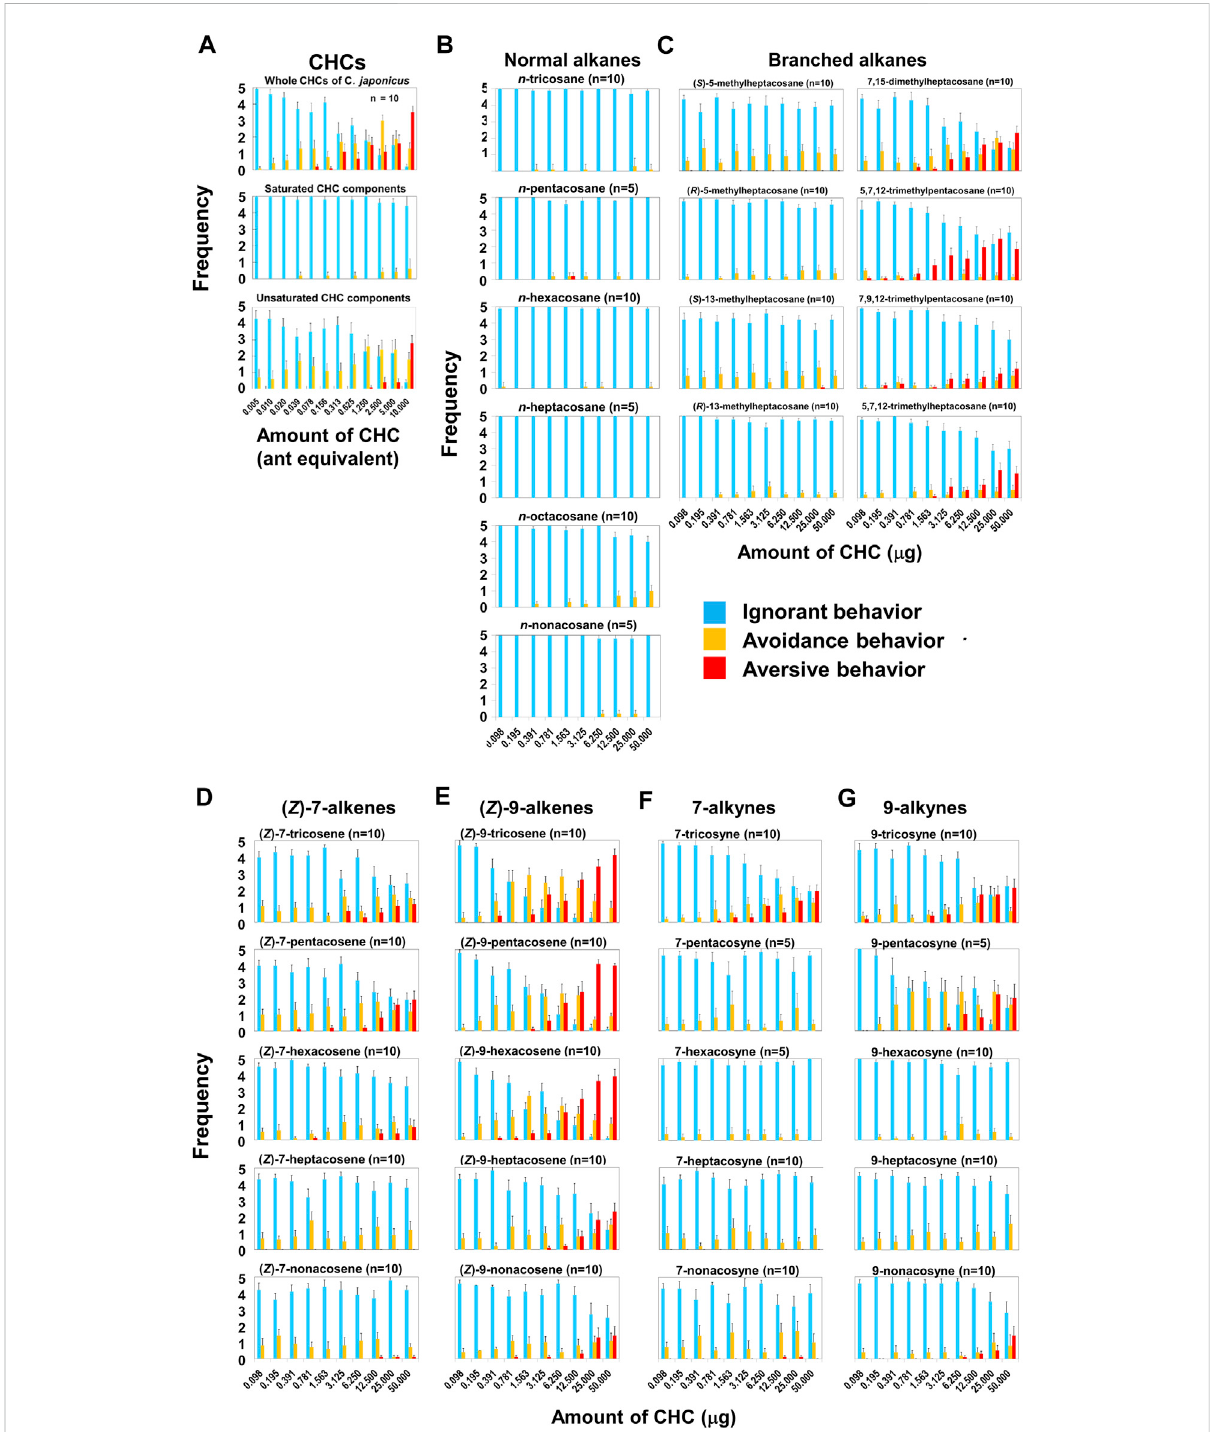
Behavioraleffectsof C.japonicus cuticularhydrocarbons(CHCs)andrelatedsyntheticcompoundson L.humile . (A) Behavioraleffectsofwhole C. japonicus CHC extracts (Top), and puri fi ed saturated (Middle) and unsaturated (Bottom) fractions. (B – E) Behavioral effects of normal alkanes, branched alkanes, ( Z )-7-alkenes and ( Z )-9-alkenes, respectively. (F,G) Behavioral effects of 7-alkynes and 9-alkynes, respectively. In Figures 1, 4, 9, blue, yellow, and red columns indicate the average frequencies of ignore, avoidance and aversive behaviors with standard errors,